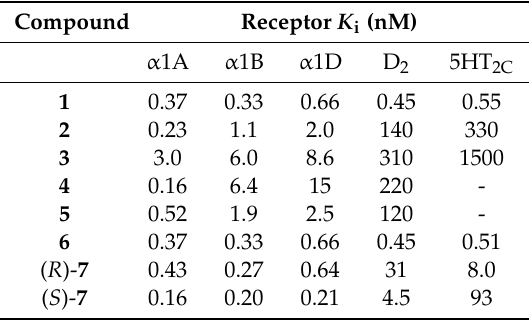
Table 2. In vitro a ffi nities of compounds 1 to 7 for α 1-ARs, D 2 and 5HT 2C receptors [73,75,76]. Compound Receptor K i (nM) α 1A α 1B α 1D 5HT